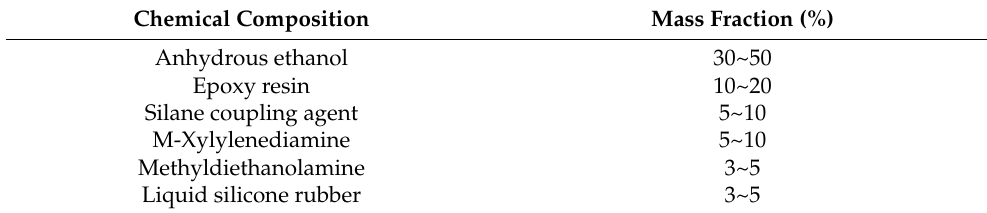
Table 3. Chemical compositions of HC-1 gel agent.